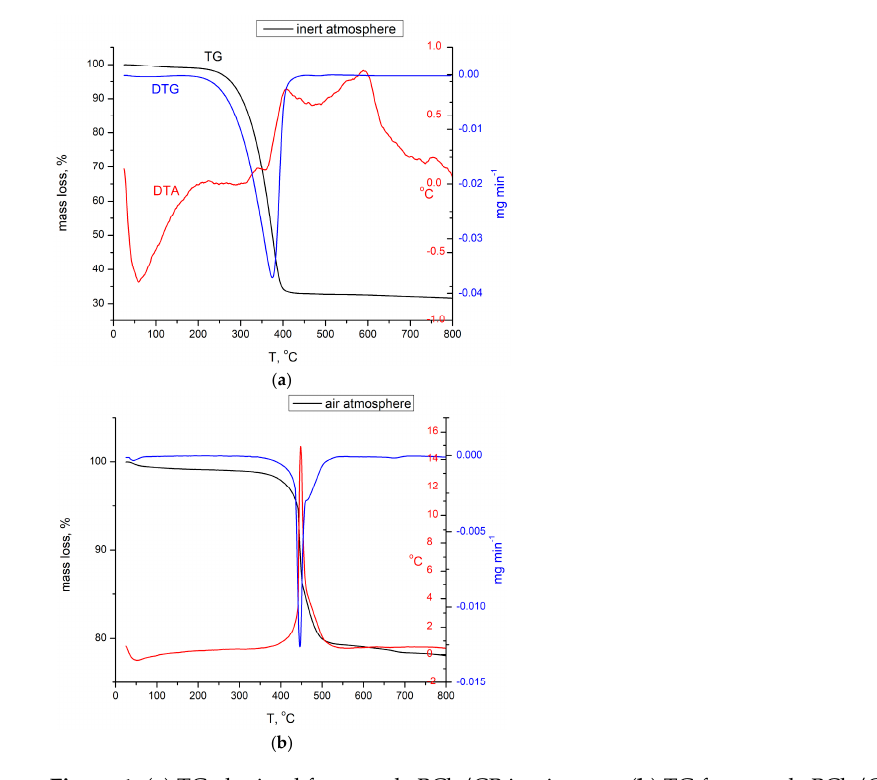
Figure 1. ( a ) TG obtained for sample BCb/CB in nitrogen. ( b ) TG for sample BCb/CB in